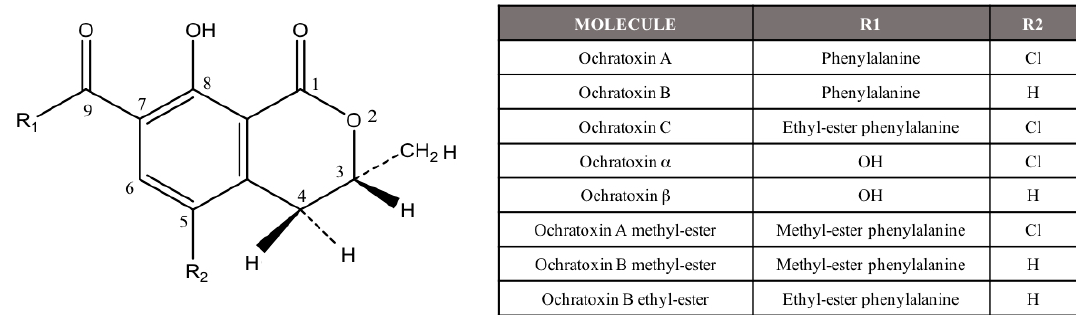
Figure 1. Chemical structure of the main natural occurring mycotoxins.